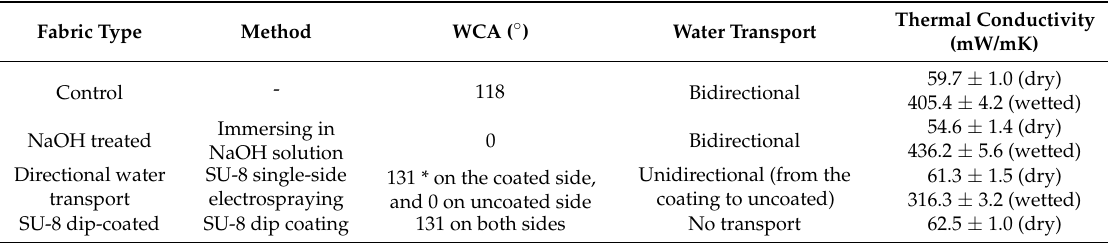
Table 1. Comparison between the control fabric, NaOH pre-treated fabric, directional water transport fabric and SU-8 dip-coating